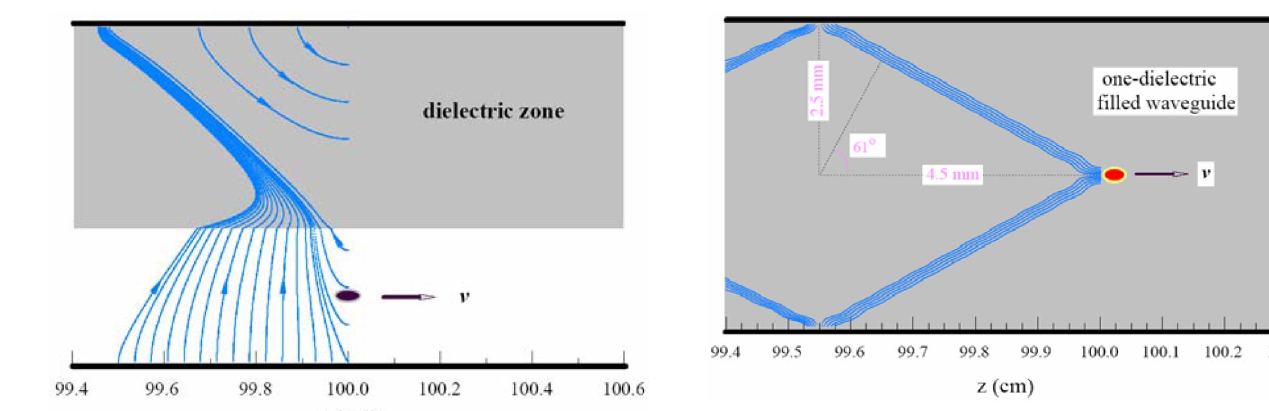
FIG. 12. (Color) Electric field force lines on the x - z symmetric plane with respect to y , excited by a 0.5-MeV, 1-nC point bunch located at the cross section center ( x (cid:4) 2 : 5 mm , y (cid:4) 0 ) and z (cid:4) 100 cm in the one-dielectric-filled rectangular waveguide with a width of 5 mm and a height of 40 mm, and with " (cid:4) 1 . In calculations, 400 (200 LSM and 200 LSE) modes are (cid:1) r included. It is seen that the apparent C˘ erenkov angle tan (cid:5) 1 (cid:1) 4 : 5 = 2 : 5 (cid:2) (cid:4) 60 : 95 (cid:16) is in very good agreement with 60 : 96 (cid:16) given by the classic formula cos (cid:5) 1 (cid:1) 1 =(cid:3) (cid:1)(cid:1)(cid:1)(cid:1)(cid:1)(cid:1)(cid:1)(cid:1)(cid:1)(cid:1)(cid:1) "